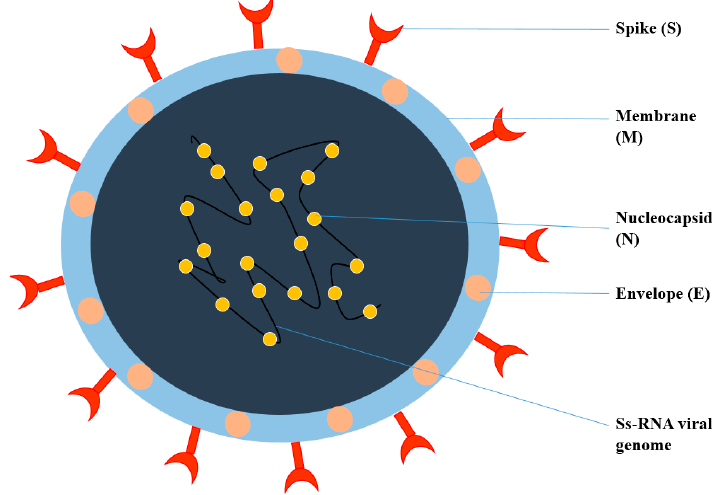
Figure 1. Structure of Coronavirus.